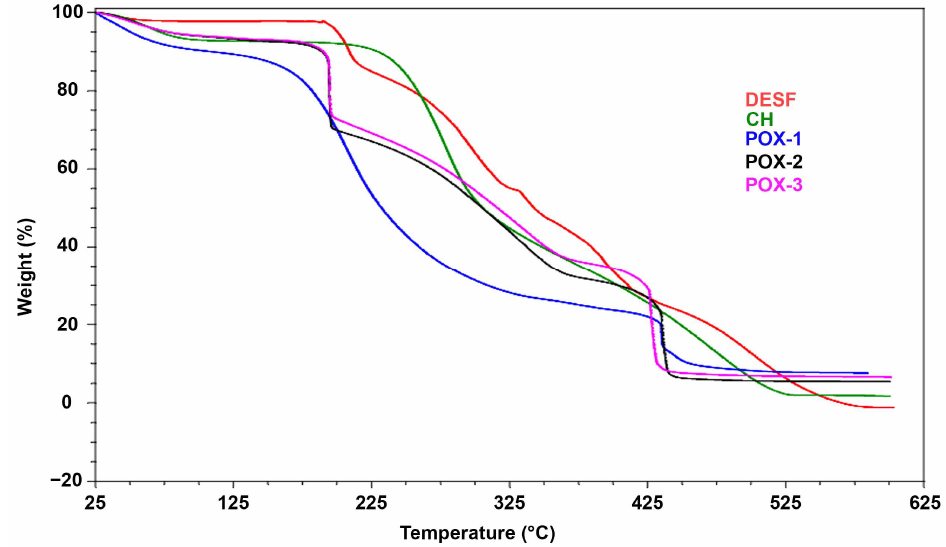
Figure 4. TGA curves of DESF, CH, POX-1, POX-2, POX-3.